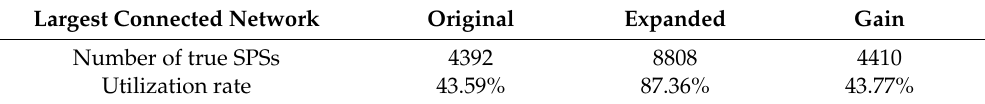
Table 2. Utilization rate of true SPSs between original and expanded largest